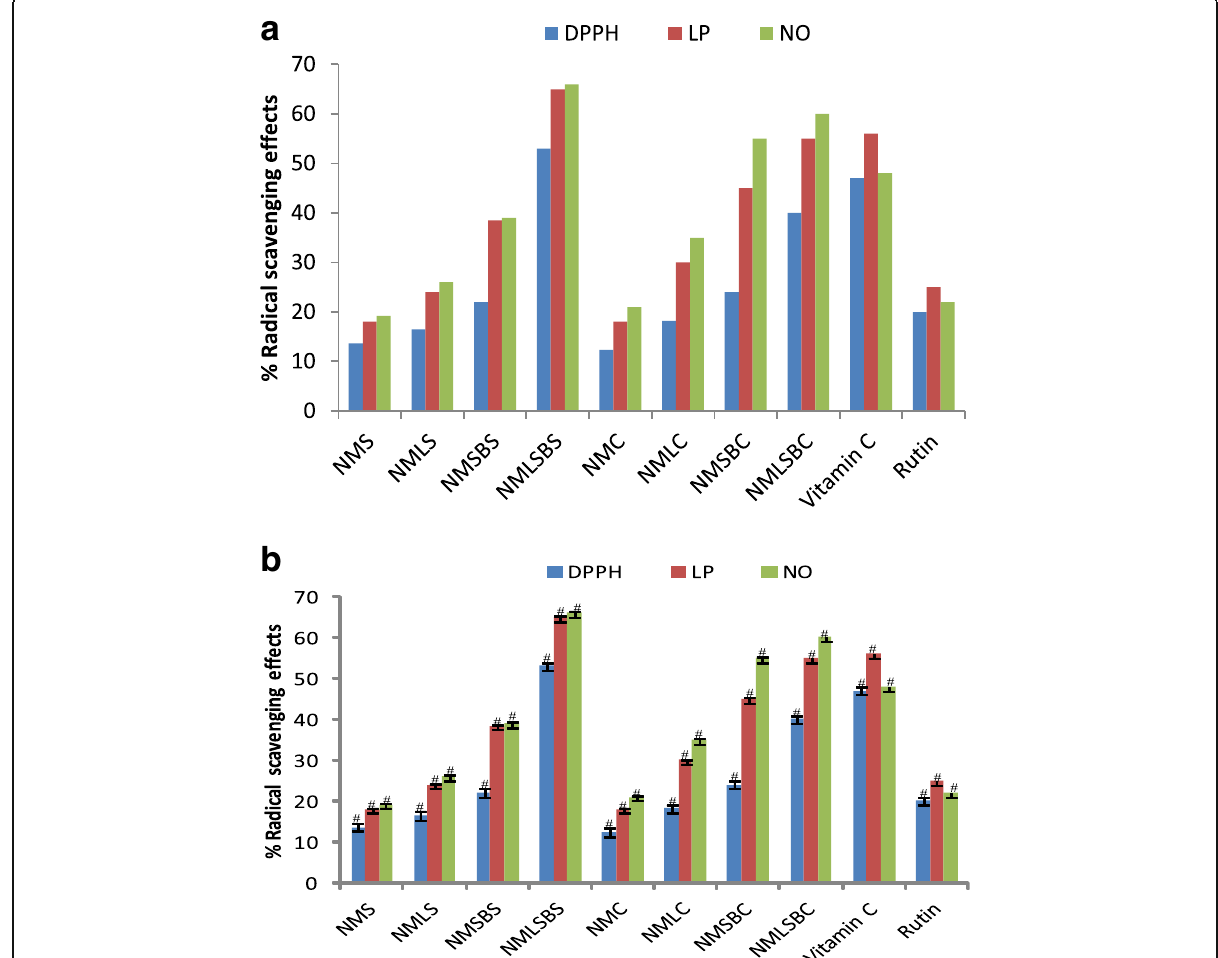
Fig. 1 a Radical scavenging effects of neem cosmetics with and without secondary metabolites and reference compounds at 0.10mg/mL. b Radical scavenging effects of neem cosmetics with and without secondary metabolites and reference compounds at 0.10mg/mL (#=significantly different, s=not significantly different p